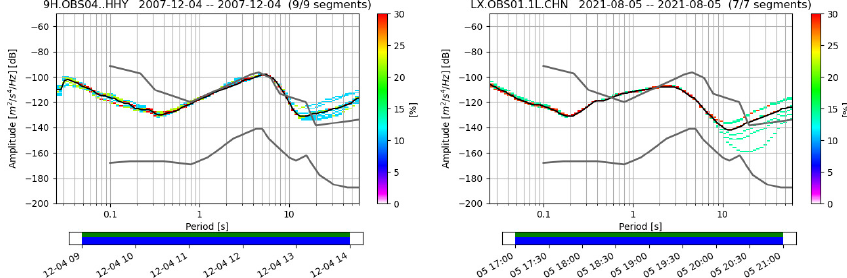
Figure 14. Response – the response of CMG-40T and Aquarius seismometer, both from Güralp, to laminar flow. The Güralp CMG-40T (9H OBS04) has a standard response between 10s–40Hz and exceeds the new low noise model for periods above 10s. The Güralp Aquarius (LX OBS01) shows − 160dB re((ms − 2 ) 2 Hz − 1 ) between 15 and